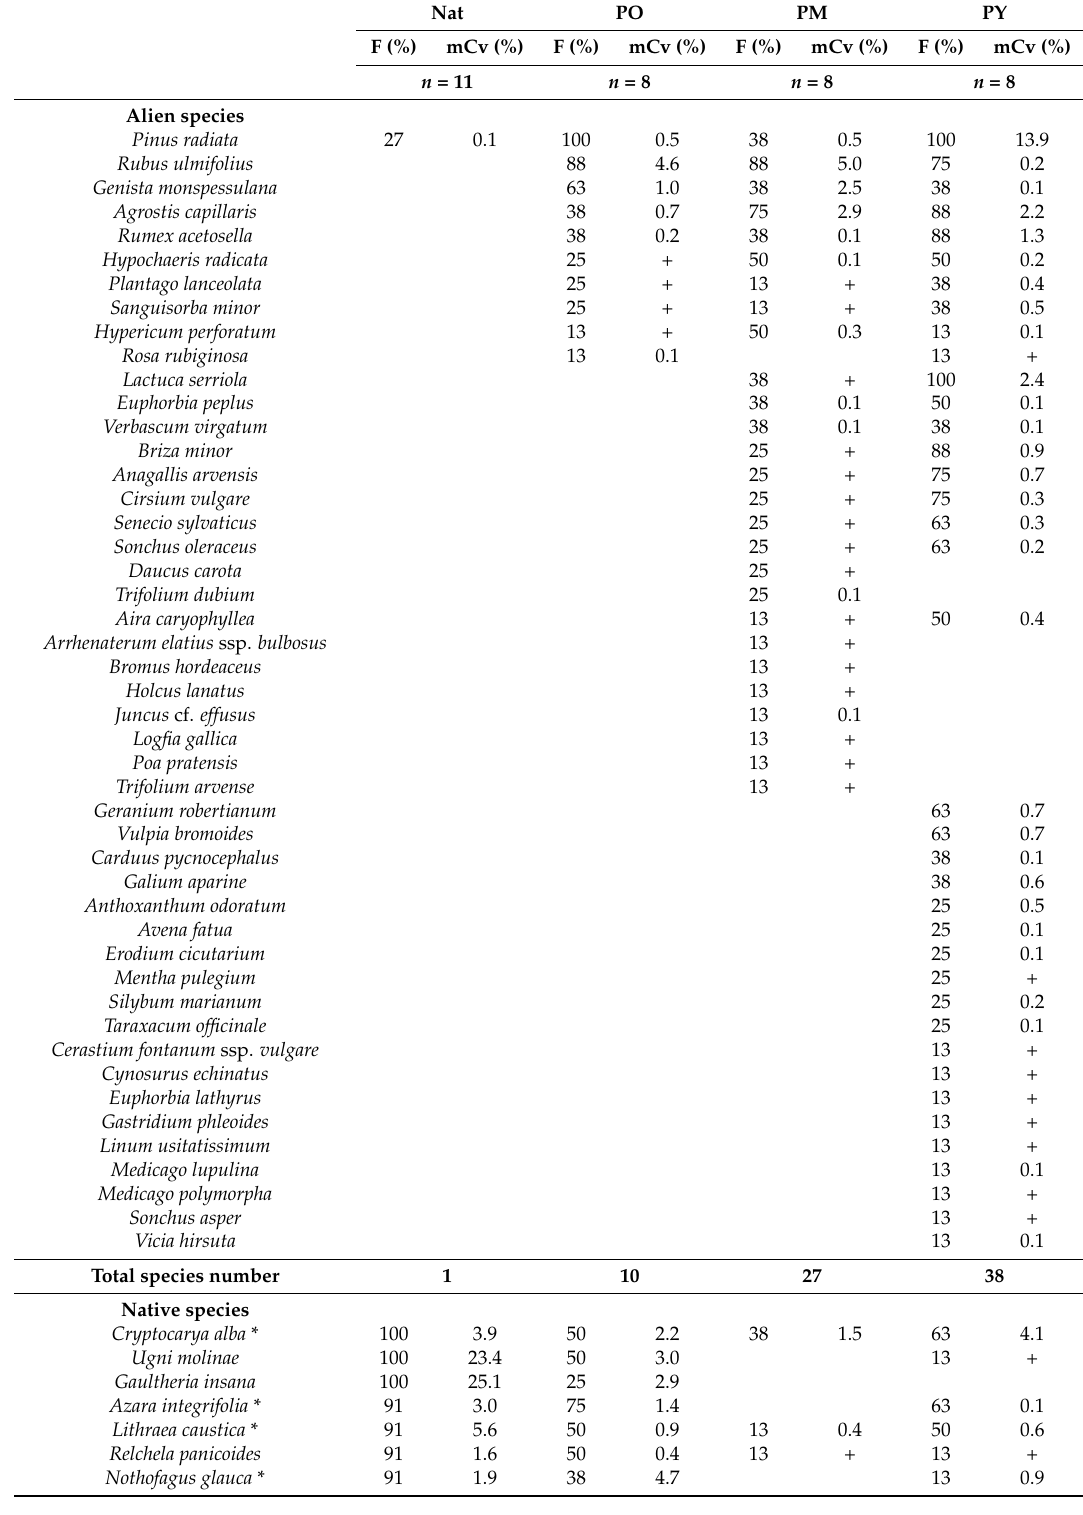
Table A2. Species recorded in forest interior transects of the natural forest (Nat), old to mature pine plantation (PO), medium-aged pine plantations (PM) and young pine plantations (PY). Given are occurrence frequency values (F) representing the percentage occurrence in transects and the mean cover values (mCv) in % (cover values of + are < 0.05%). Alien and native origin according to Zuloaga et al. [48]. * marks endemic species. Species are ordered based on their decreasing frequency from the natural forest to young